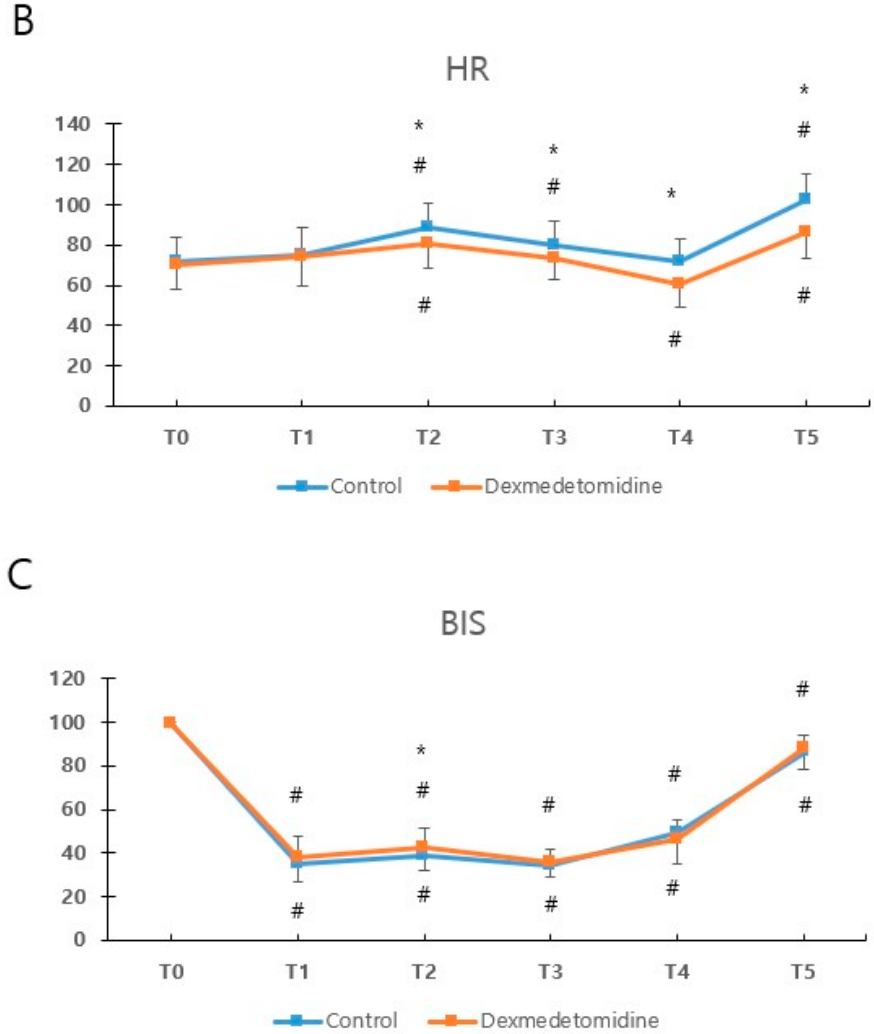
Figure 3. Hemodynamic changes during anesthesia and surgery. MAP ( A ), mean arterial pressure; HR ( B ), heart rate; BIS ( C ), bispectral index. Data are expressed as mean ± standard deviation. T0, baseline; T1, before endotracheal intubation; T2, surgical incision; T3, 10 min after CO 2 insufflation; T4, end of surgery; T5, after extubation. * p < 0.05 compared with two groups. # Bonferroni-adjusted p < 0.05 compared with T0.